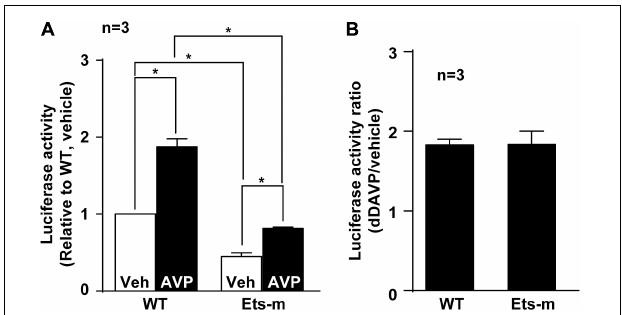
FIGURE 6 | Ets mutation reduced basal and vasopressin-induced AQP2 promoter activity. (A) Wild type (WT) and Ets mutant (Ets-m) AQP2 promoter activity assay. WT or Ets-m AQP2 promoter (1,000 bp) was transfected into the mpkCCD cells before stimulated with vehicle (Veh) or dDAVP (AVP) prior to reporter activity assay. Values are means ± SE, normalized against values of the wild type promoter under the vehicle conditions. Asterisk indicates significance ( p < 0.05, t -test). (B) Ratios of the AQP2 promoter activity in response to dDAVP vs.